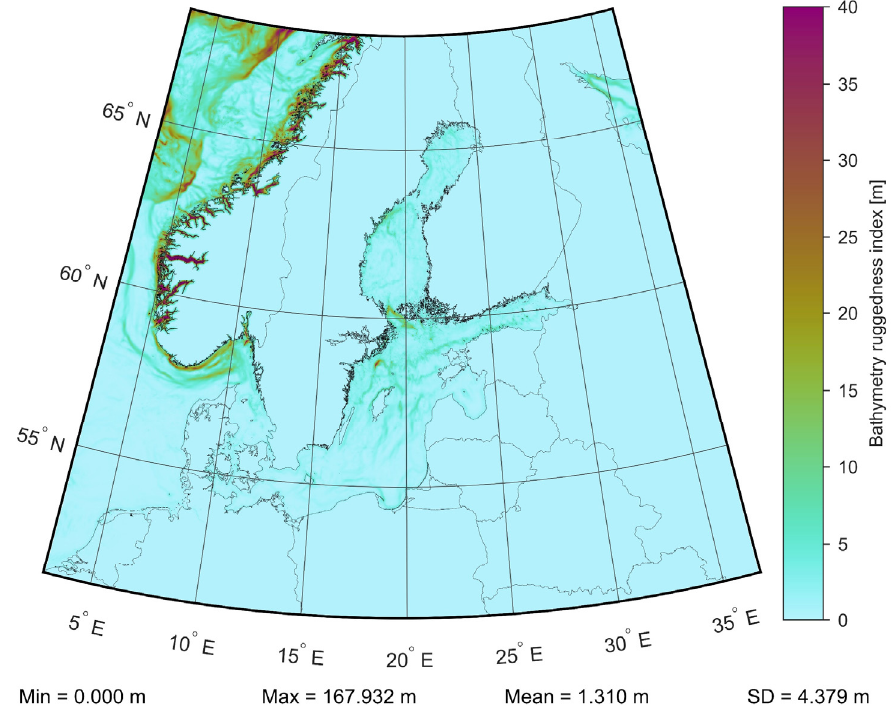
Figure 3. Estimated ruggedness of bathymetry.